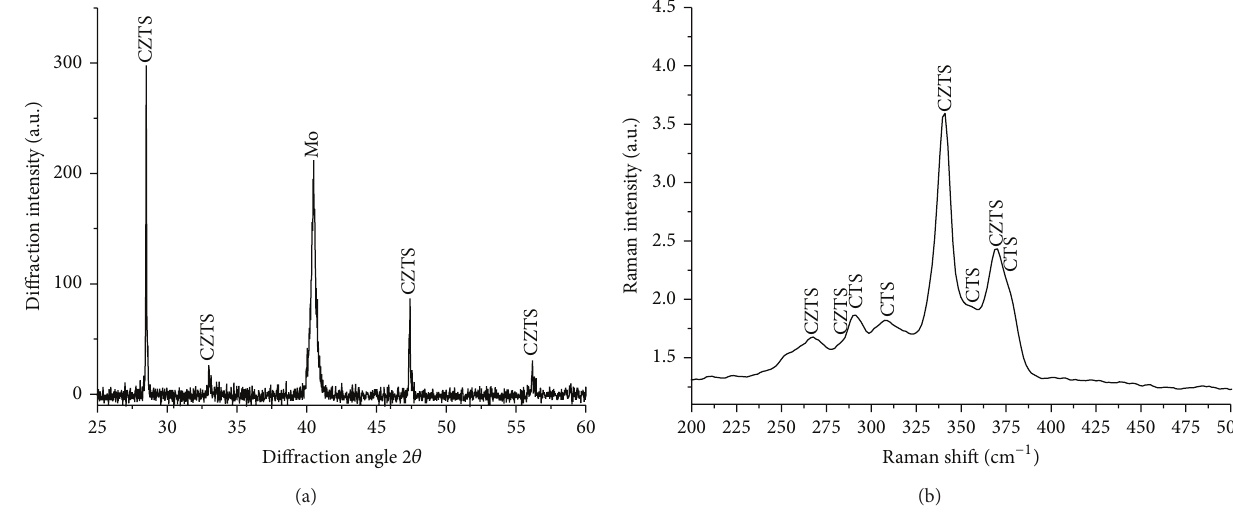
Figure 2: (a) XRD pattern and (b) Raman spectrum of the Cu-poor/Zn-rich CZTS layers examined in this work after the etching procedure in aqueous